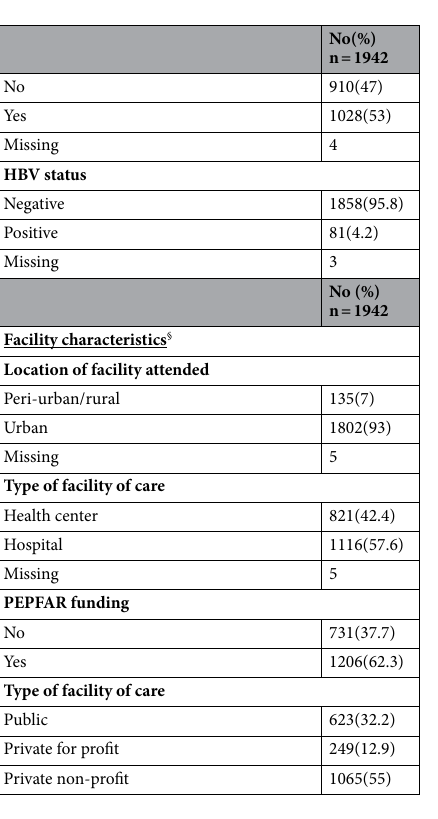
Table 1. Sociodemographic, clinical and facility characteristics of the study population. The analytical sample was derived from the enrollment data of an ongoing cluster randomized controlled trial, aimed at evaluating the effect of data-driven continuous quality improvement on long-term ART outcomes in Kinshasa, Democratic Republic of Congo. We retained participants that had available data on HCV rapid testing. SES, socio-economic status; RNA, ribonucleic acid, ART, antiretroviral therapy, HBV, hepatitis B virus. **Self- report of disclosure of HIV status to anyone. § Facility at which participant was enrolled/tested. ¶ Calculated using principal component analysis and categorized in three groups: the lower first two quintiles, the middle quintiles, and the last two quintiles. # Self-report of emotional or physical or sexual partner